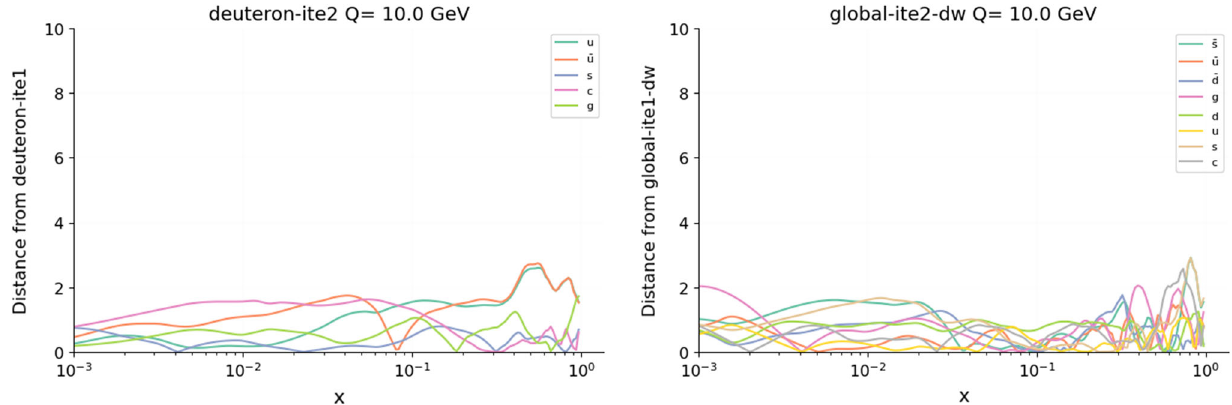
Fig. 5 Distances between the central values of the deuteron-ite1 and deuteron-ite2 fits (left) and of the global-ite1-dw and global-ite2-dw fits (right), see Table 1 for details. For the deuteron fits, u and ¯ u actu- ally denote the combinations ( u + d )/ 2 and ( ¯ u + ¯ d )/ 2, where u = d